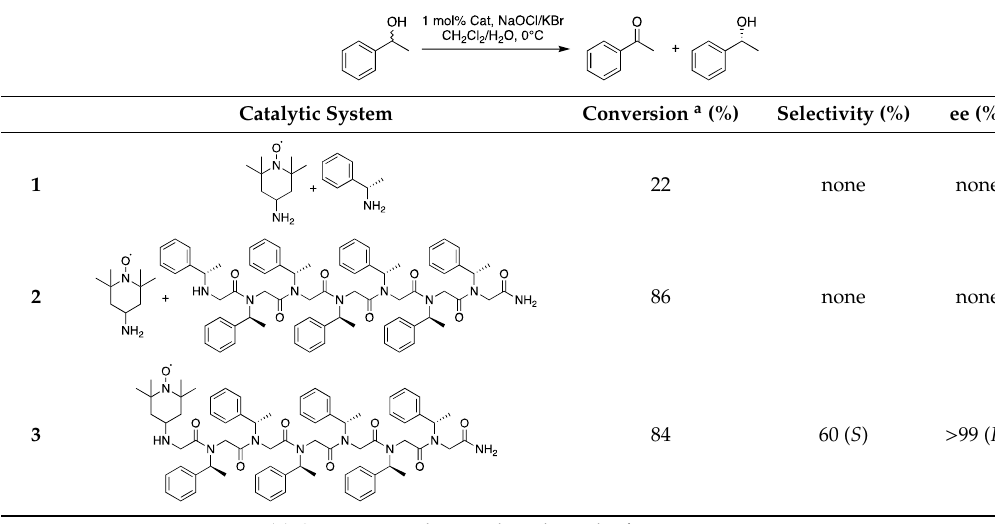
Table 1. Conversion, enantioselectivities and enantiomeric excess for the catalytic oxidation of 1-phenylethanol by the TEMPO − peptoid hybrids [44].